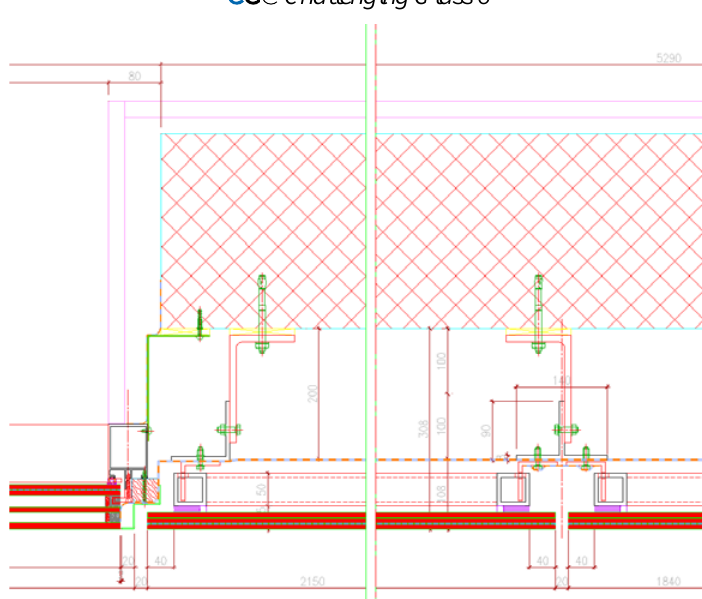
Fig. 3: Cladding horizontal section and fixed window connection